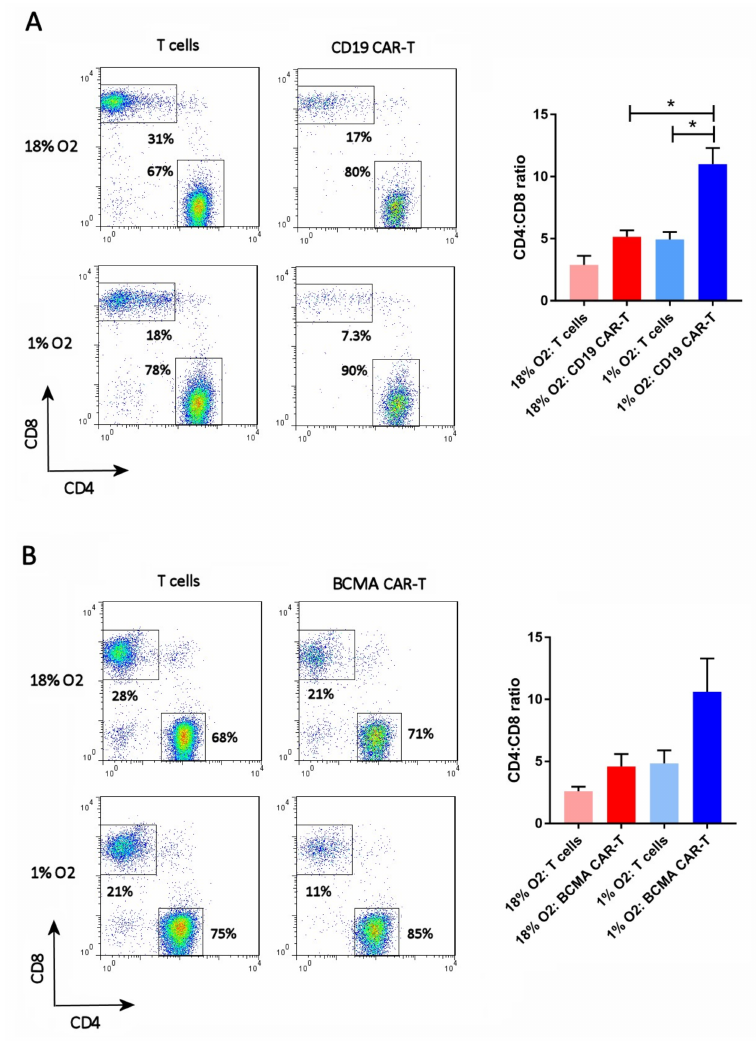
Figure 4. Hypoxia increases the CD4:CD8 ratio. CD19 CAR-T cells ( A ) and BCMA CAR-T cells ( B ) were stained with antibodies for CD27 and CD45RO, along with the anti-FLAG antibody or BCMA protein. Representative flow cytometry plots showing CD27 and CD45RO expression are on the left; the CAR-T plots show only the gated CAR-T cells. Charts showing the average and standard error of 4 separate experiments are shown on the right. * p = <